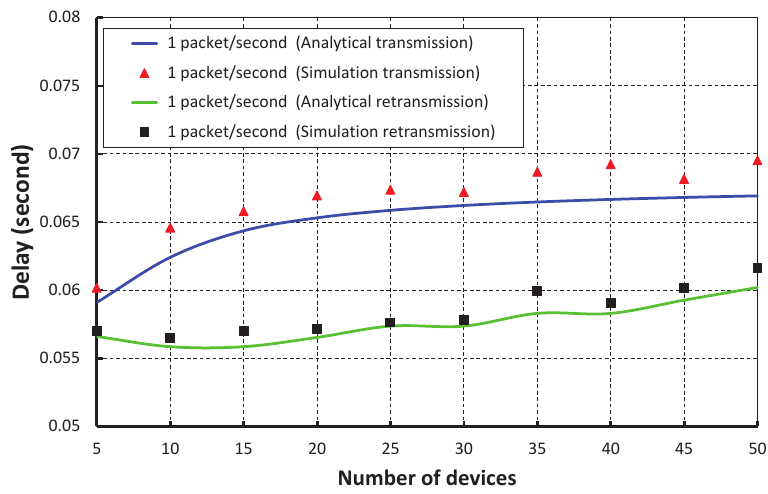
Figure 15. Validation of delay of our proposed scheme for different numbers of devices.